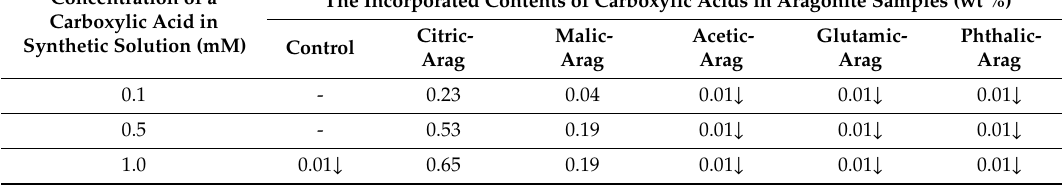
Table 3. The incorporated contents of carboxylic acids in the organic co-precipitated aragonite samples measured by